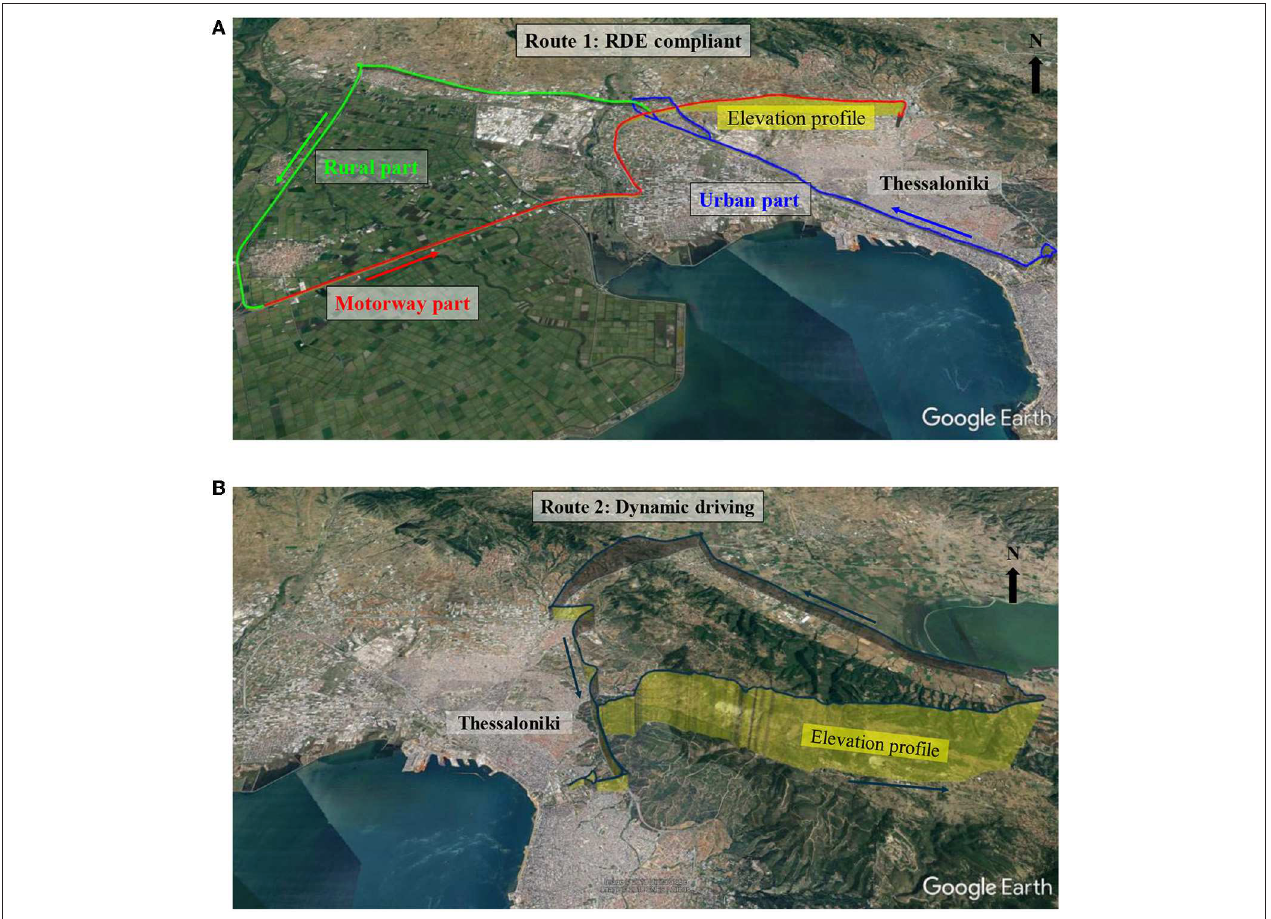
FIGURE 3 | Visualization of the on-road tests ( A : RDE compliant, B : Dynamic driving). Yellow fill denotes the local elevation.